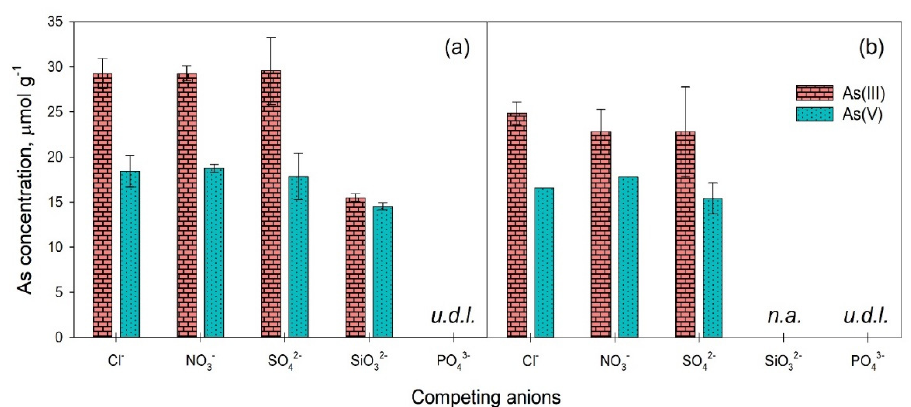
Figure 6. Concentrations of As(III) and As(V) adsorbed on Bi 2 O 3 (4 g L − 1 ) at pH 8 and 7, respectively, and 25 ± 3 °C after 24 h of equilibration in the presence of 0.01 M ( a ) and 0.1 M ( b ) Cl − , NO 3 − , SO 42 − , SiO 32 − , and PO 43 − . Error bars represent standard error.